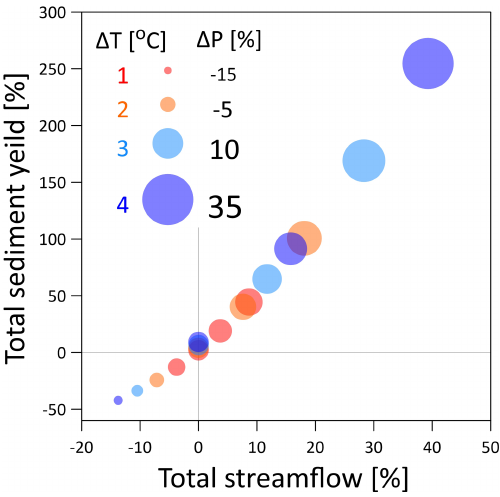
Figure 9. Changes in the total sediment yield ( y axis) as a function of the changes in total streamflow ( x axis) in relation to the changes in total rainfall amounts (symbol size, (cid:49)P for stratiform rainfall type). The relevant temperature scenario ( (cid:49)T ) is expressed by the colour of the symbols (1 ◦ C – red, 2 ◦ C – orange, 3 ◦ C – blue, and 4 ◦ C – dark blue). The reference to compute the changes is the total streamflow and sediment transport of the base scenario (at (cid:49)T =